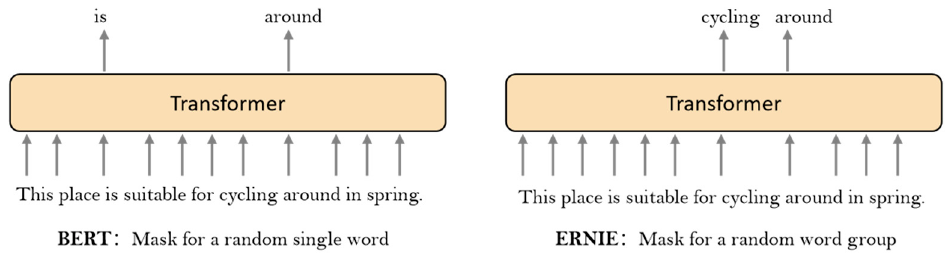
Figure 1. Comparison of BERT and ERNIE mask mechanisms.